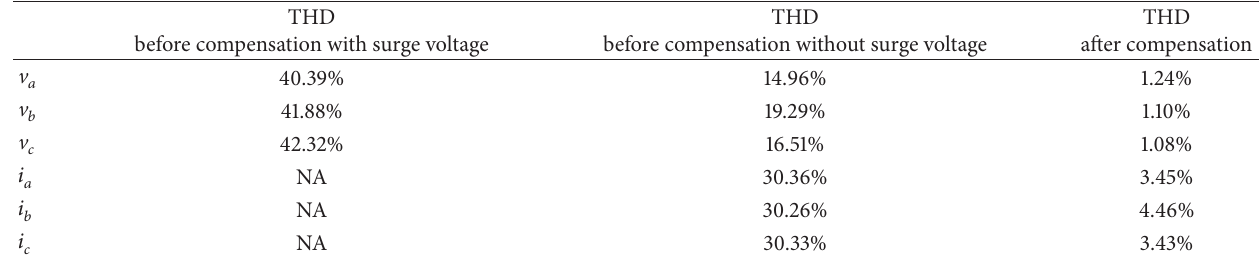
Table 2: Per-phase THD values before and after compensation.